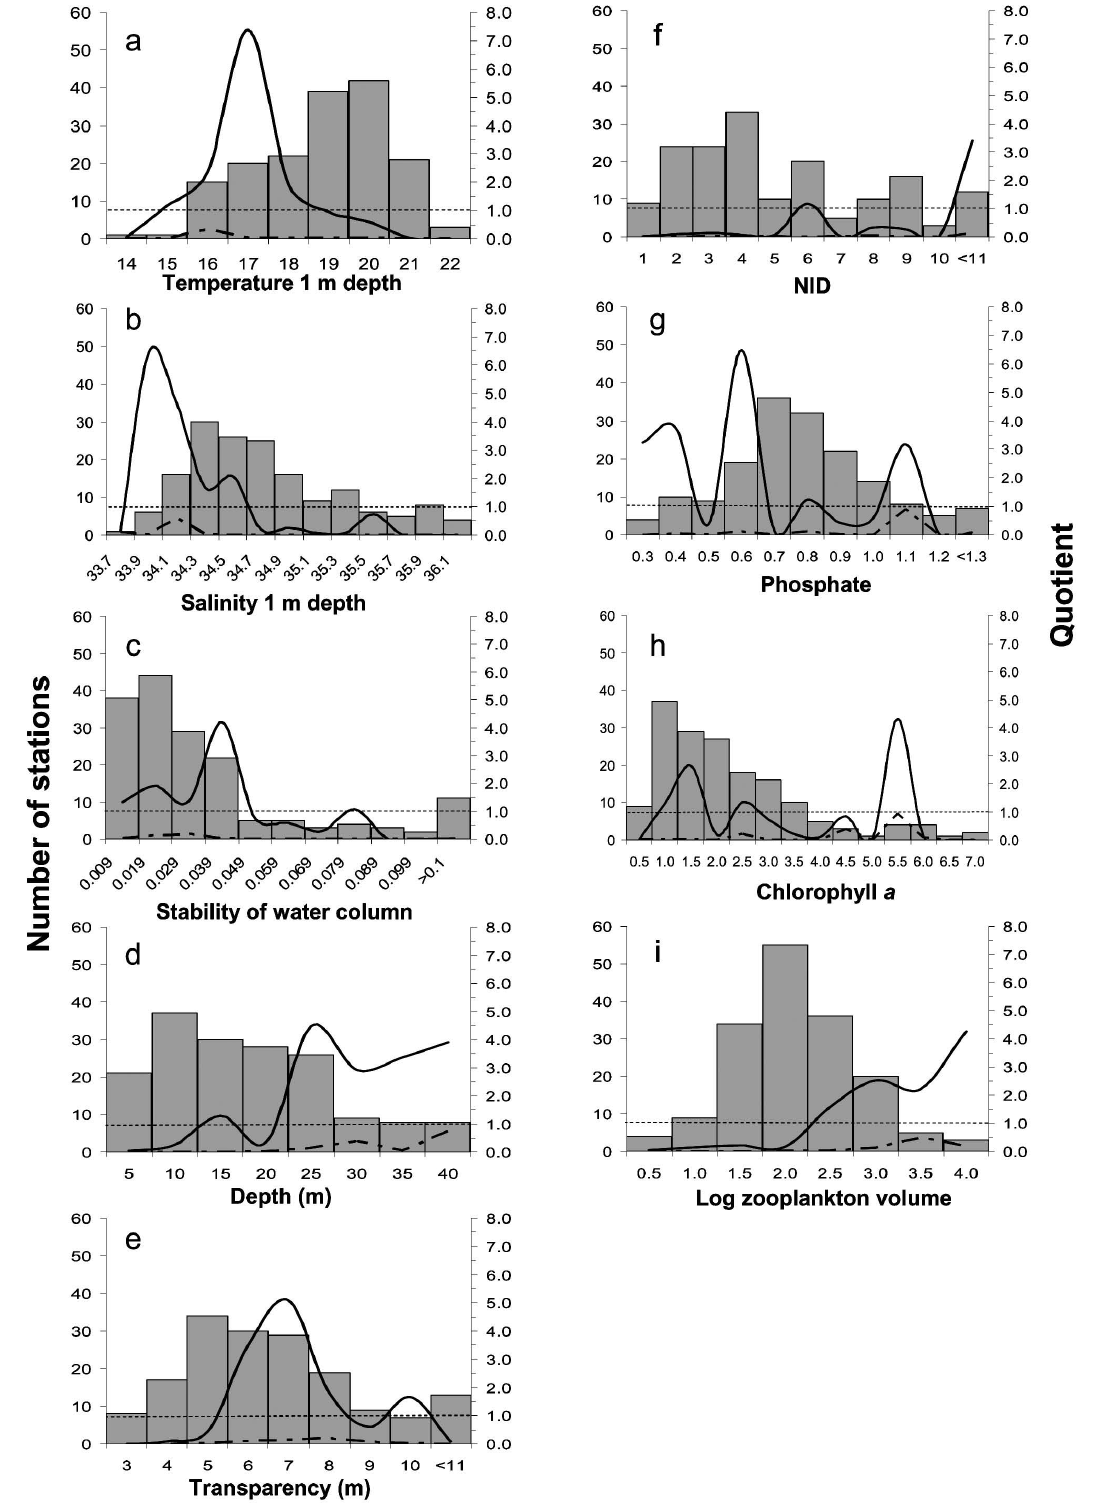
Fig . 2. – Quotient lines of egg (dark line) and larval abundance (dashed line) of Sardinops sagax in relation to: a) sea surface temperature; b) salinity; c) density gradient; d) bottom depth; e) transparency; f) NID; g) phosphate; h) chlorophyll a ; and i) zooplankton volume. Histograms indicate the number of samples taken in each class interval during winter and early spring 2005-2009 in Bahía Magdalena, Baja California Sur. Quotient=1 (horizontal dashed